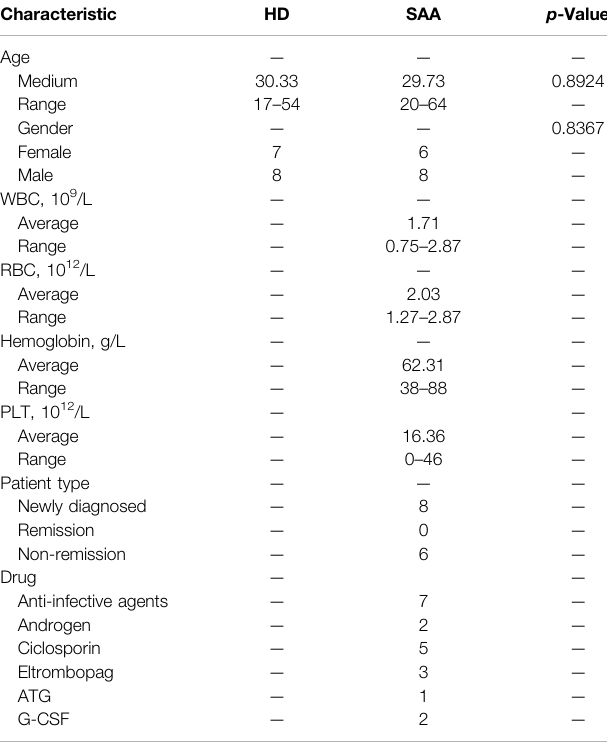
TABLE 1 | Clinical characteristics of the study